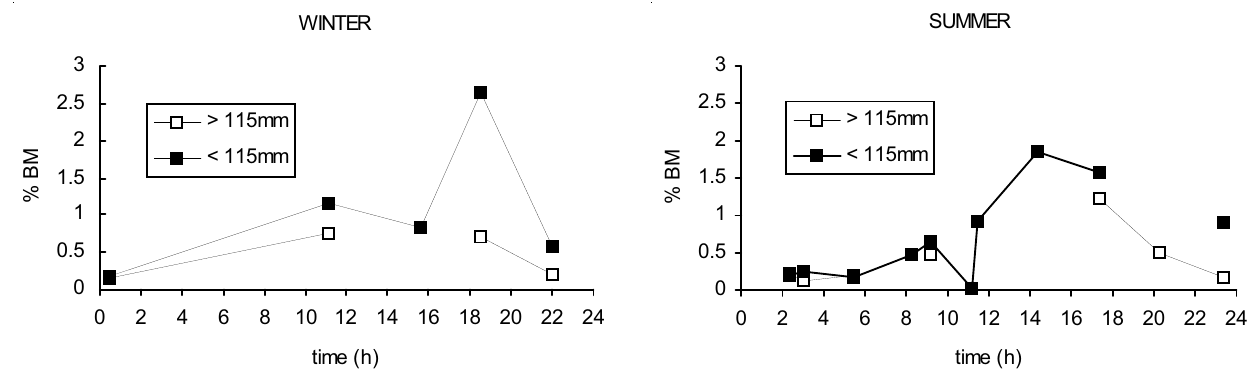
Fig. 5. Mean of stomach index of fullness expressed as BM% (mass of the stomach content x mass of the fish -1 x 100) of adult (> 115mm) and juvenile (< 115mm) Trachurus lathami by sampling period from Ubatuba shelf, in winter and